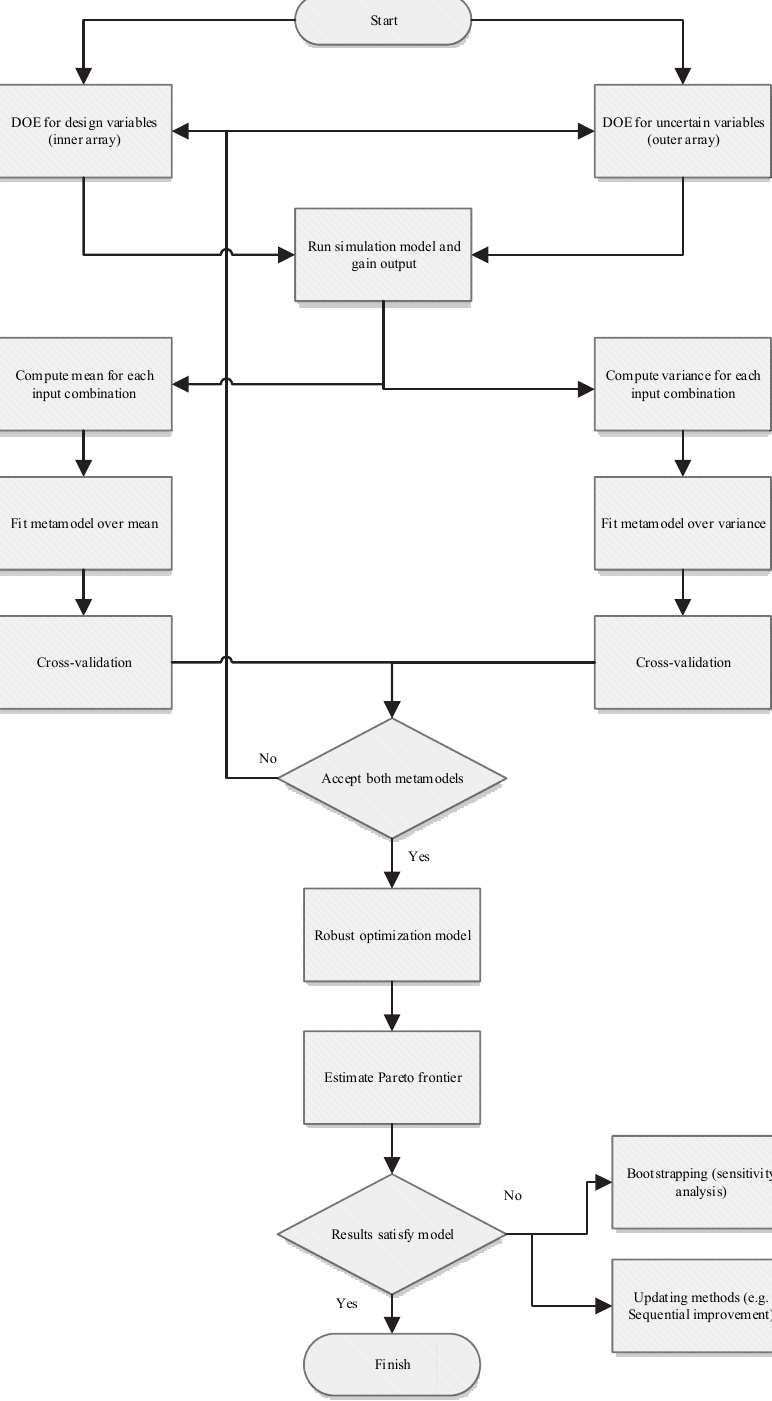
Fig. 11. Main steps in MBRSO